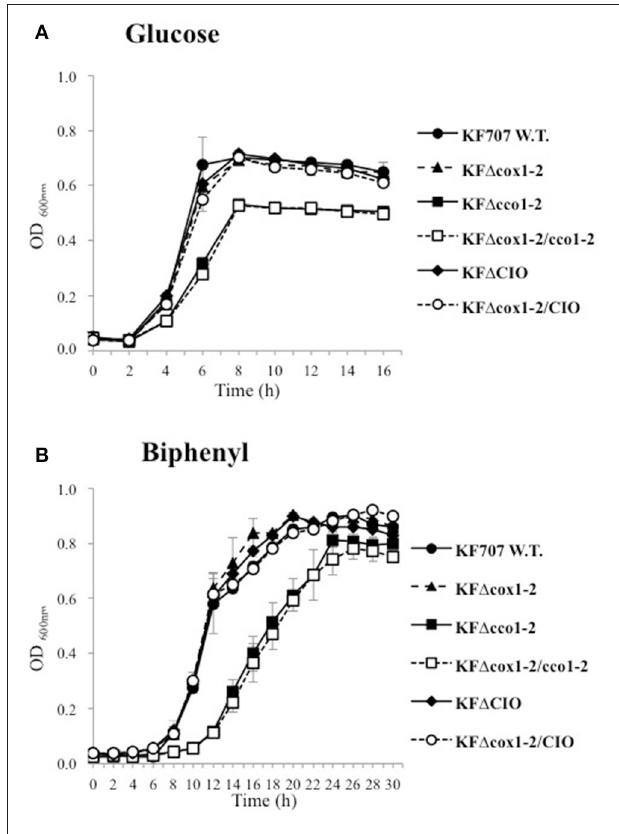
FIGURE 3 | Growth curves of KF707 W.T. and deletion mutant strains ( Table 1 ). Strains were grown in 50mL of MSM medium in 250mL flasks shaken at 130 r.p.m, with 6mM of glucose (A) or biphenyl (B) . The optical densities were observed at 600nm every 2h. Growths were stopped at late-stationary phase, after 16 and 30h, respectively for medium containing glucose or